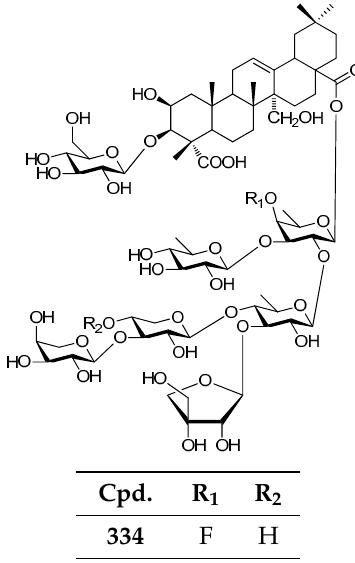
Figure 72. Structure of compound 334 .